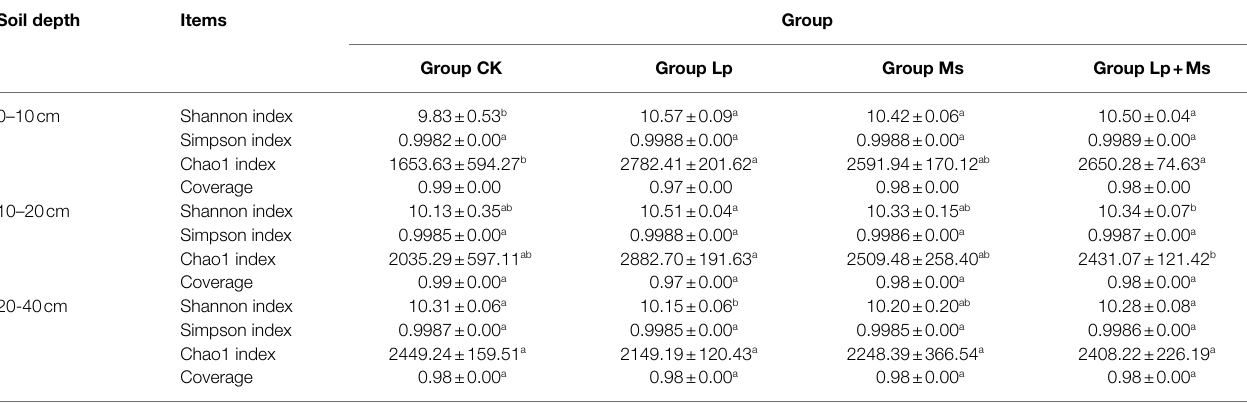
TABLE 1 | Effects of different interrow grasses on Alpha diversity of soil bacteria. Soil depth